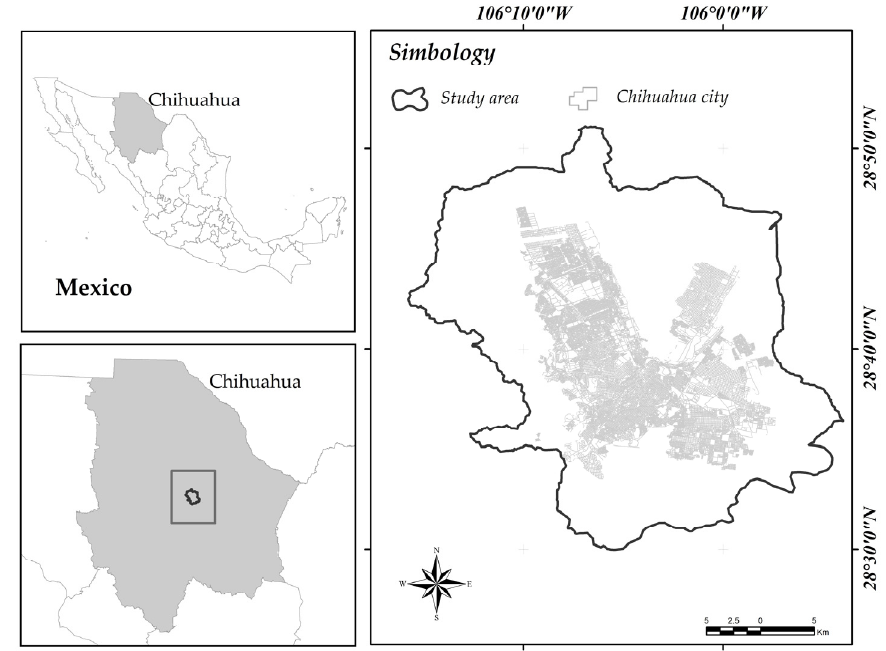
Figure 1. Location of the study area.